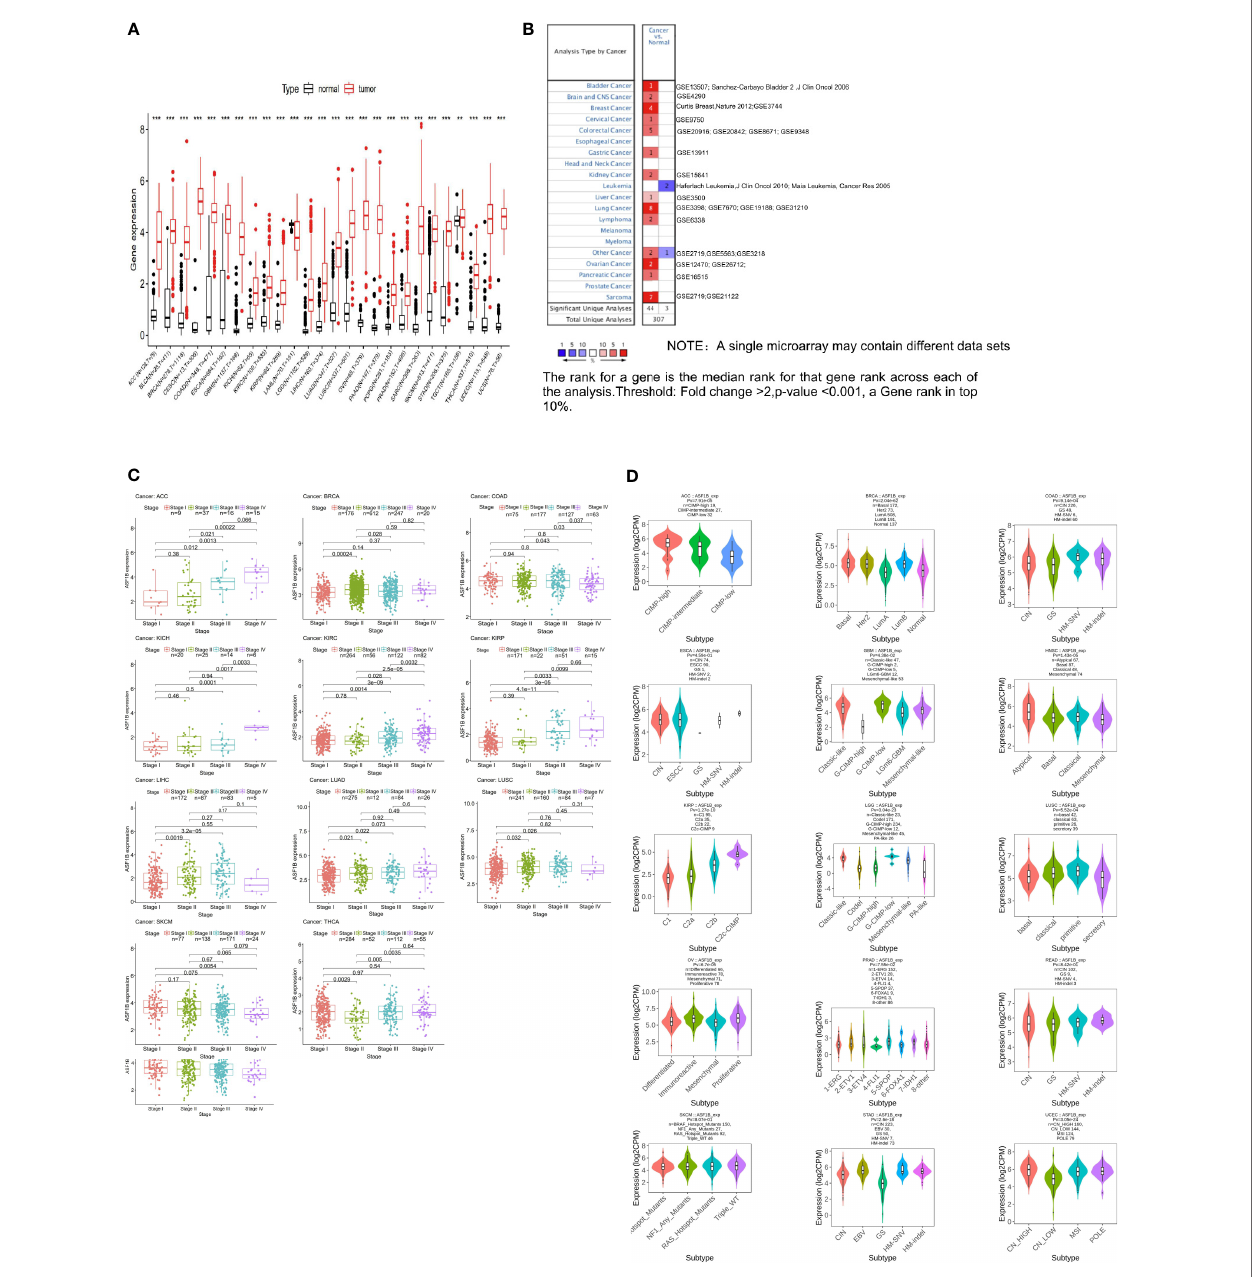
FIGURE 1 | The transcription levels of ASF1B in human cancers. (A) The mRNA expression of ASF1B between tumor and normal tissues was analyzed by using tissues from TCGA and GTEx. (B) The mRNA expression of ASF1B between tumor and normal tissues was analyzed by using tissues from Oncomine. (C) Correlations of ASF1B expression with different clinical stages in patients with different cancers from TCGA. (D) ASF1B expression in different molecular subtypes of cancers via TISIDB database (**p value ≤ 0.01; ***p value ≤